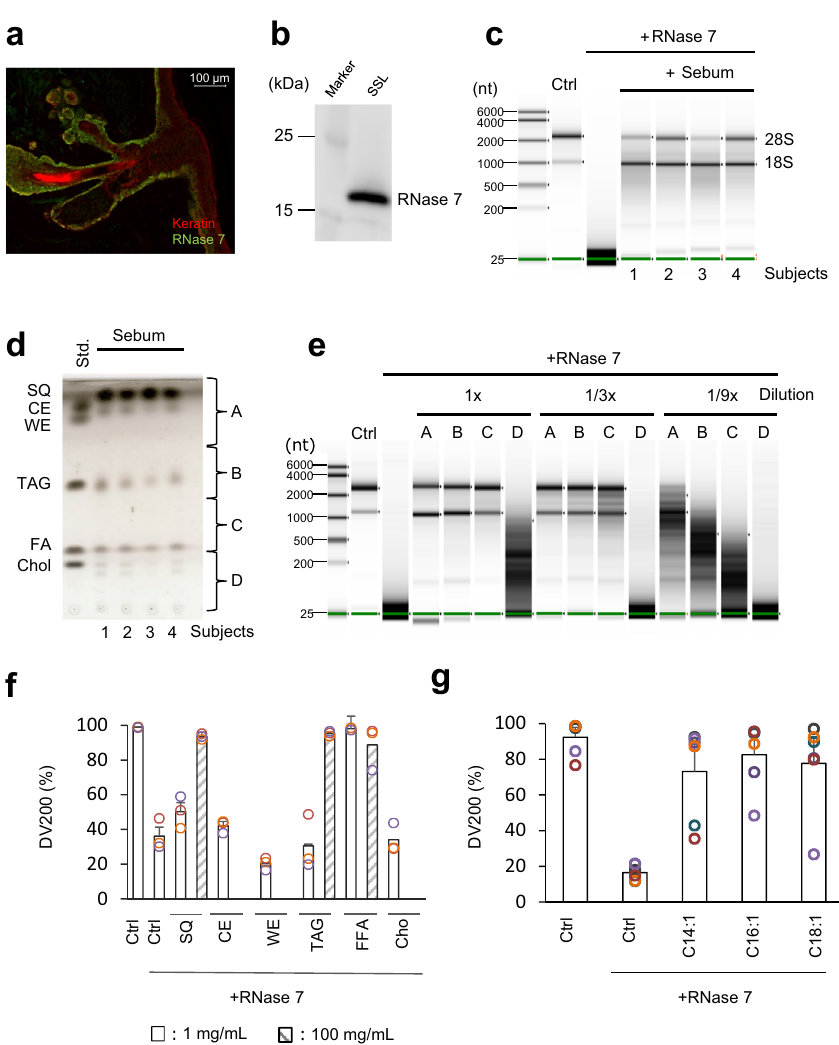
Fig. 2 Effect of sebum lipids on RNase activity. a The localization of RNase 7 in the human skin. Green, RNase 7; red, keratin/cytokeratin. Bar: 100 μ m. b The detection of RNase 7 in SSLs collected from healthy males by western blotting. c Determination of the effect of sebum lipids collected from four healthy males on RNase activity using NHEK total RNA. d Fractionation of sebum lipids collected from four healthy males by performing thin-layer chromatography (TLC). The standard lane (Std) includes authentic samples: SQ squalene; CE cholesterol ester (cholesteryl palmitate); WE wax ester (lauryl palmitoleate); TAG triacylglycerol (glyceryl trioleate); FA free fatty acid (palmitoleic acid); and Chol cholesterol. A to D sebum samples were collected, and lipids were extracted from the silica gel for the subsequent assays. e Effect of pooled sebum lipids collected from A to D on RNase activity using NHEK RNA. f Effect of each lipid on RNase activity using NHEK RNA. The DV200 values are shown as the mean with the standard error of the mean (SEM), n = 3. WE, wax ester (behenyl palmitoleate); TAG, triacylglycerol (glyceryl tripalmitoleate); Ctrl; EtOH. g Relationship between RNase activity and chain length of fatty acids. The DV200 values are shown as the mean with SEM, n = 6. C14:1, myristoleic acid; C16:1, palmitoleic acid; C18:1, oleic acid; Ctrl;